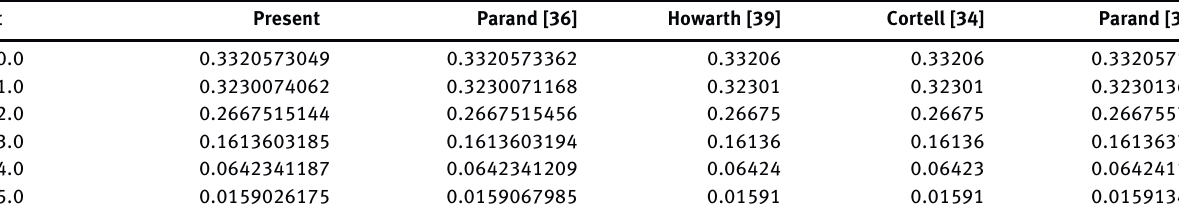
Table 13: Comparison of the obtained values of y ′′ ( t ) for various values of t by the present method, Parand et al. [3, 36], Howarth [39], and Cortell [34] t